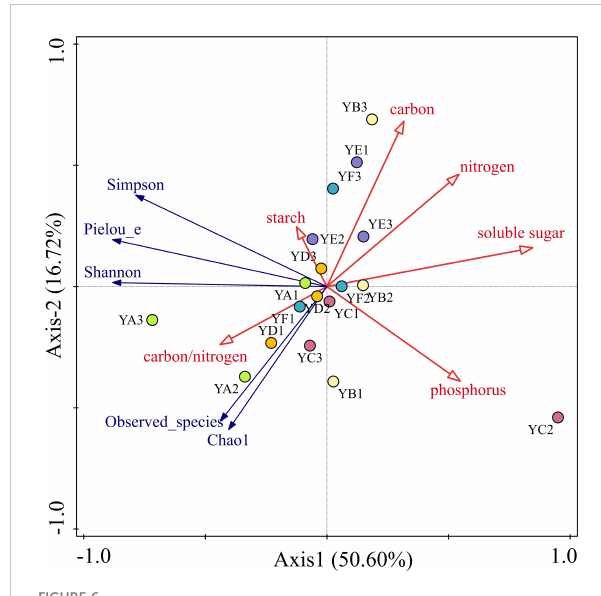
FIGURE 6 Redundancy analysis (RDA) of leaf nutrient factors and alpha diversity of phyllosphere bacterial communities. YA: Populus x euramaricana 'Bofeng 3 hao'; YB: P. deltoides 'Shanghaiguan' P. deltides 'Harvard';